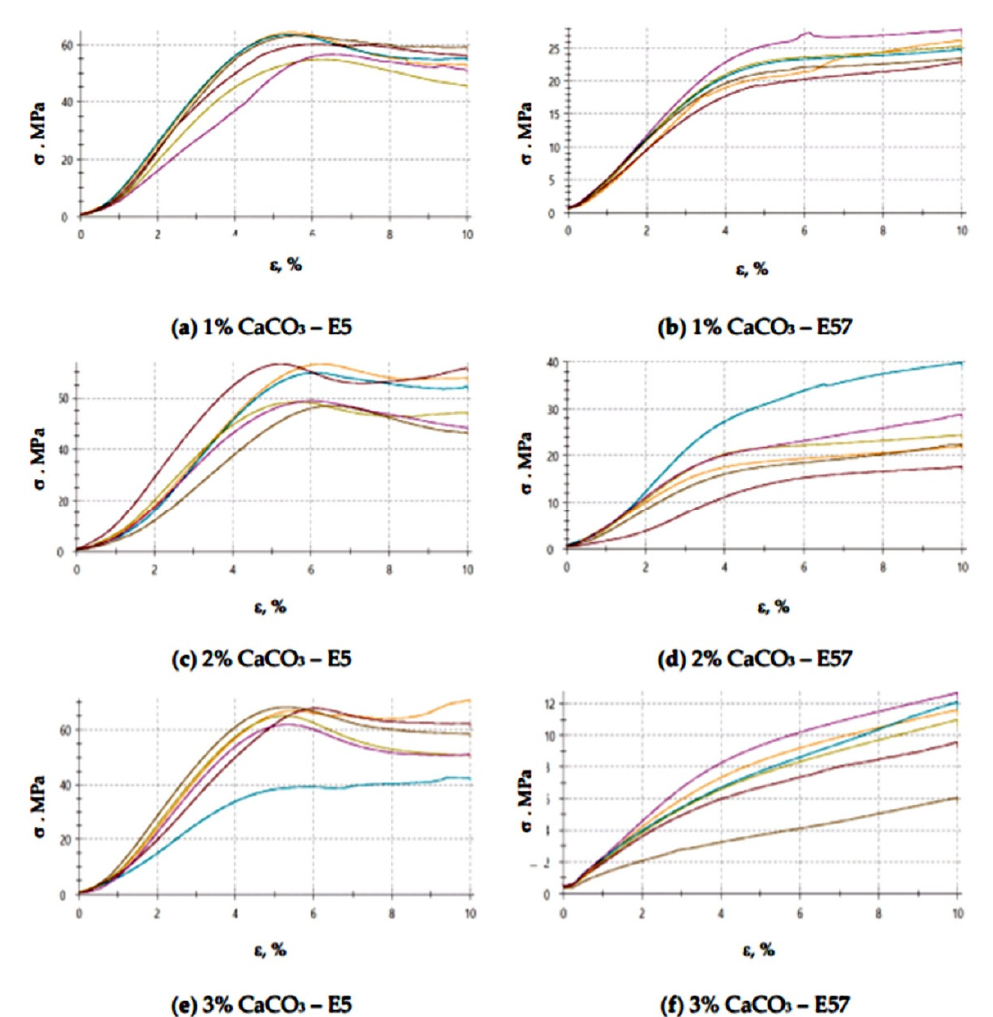
Figure 14. Stress–strain curves of the E5 / PAC / 100:80 and E57 / PAC / 100:80 epoxy specimens modified by the calcium carbonate filler post-climate chamber aging: ( a ) 1% CaCO 3 —E5, ( b ) 1% CaCO 3 —E57, ( c ) 2% CaCO 3 —E5, ( d ) 2% CaCO 3 —E57, ( e ) 3% CaCO 3 —E5, ( f ) 3% CaCO 3